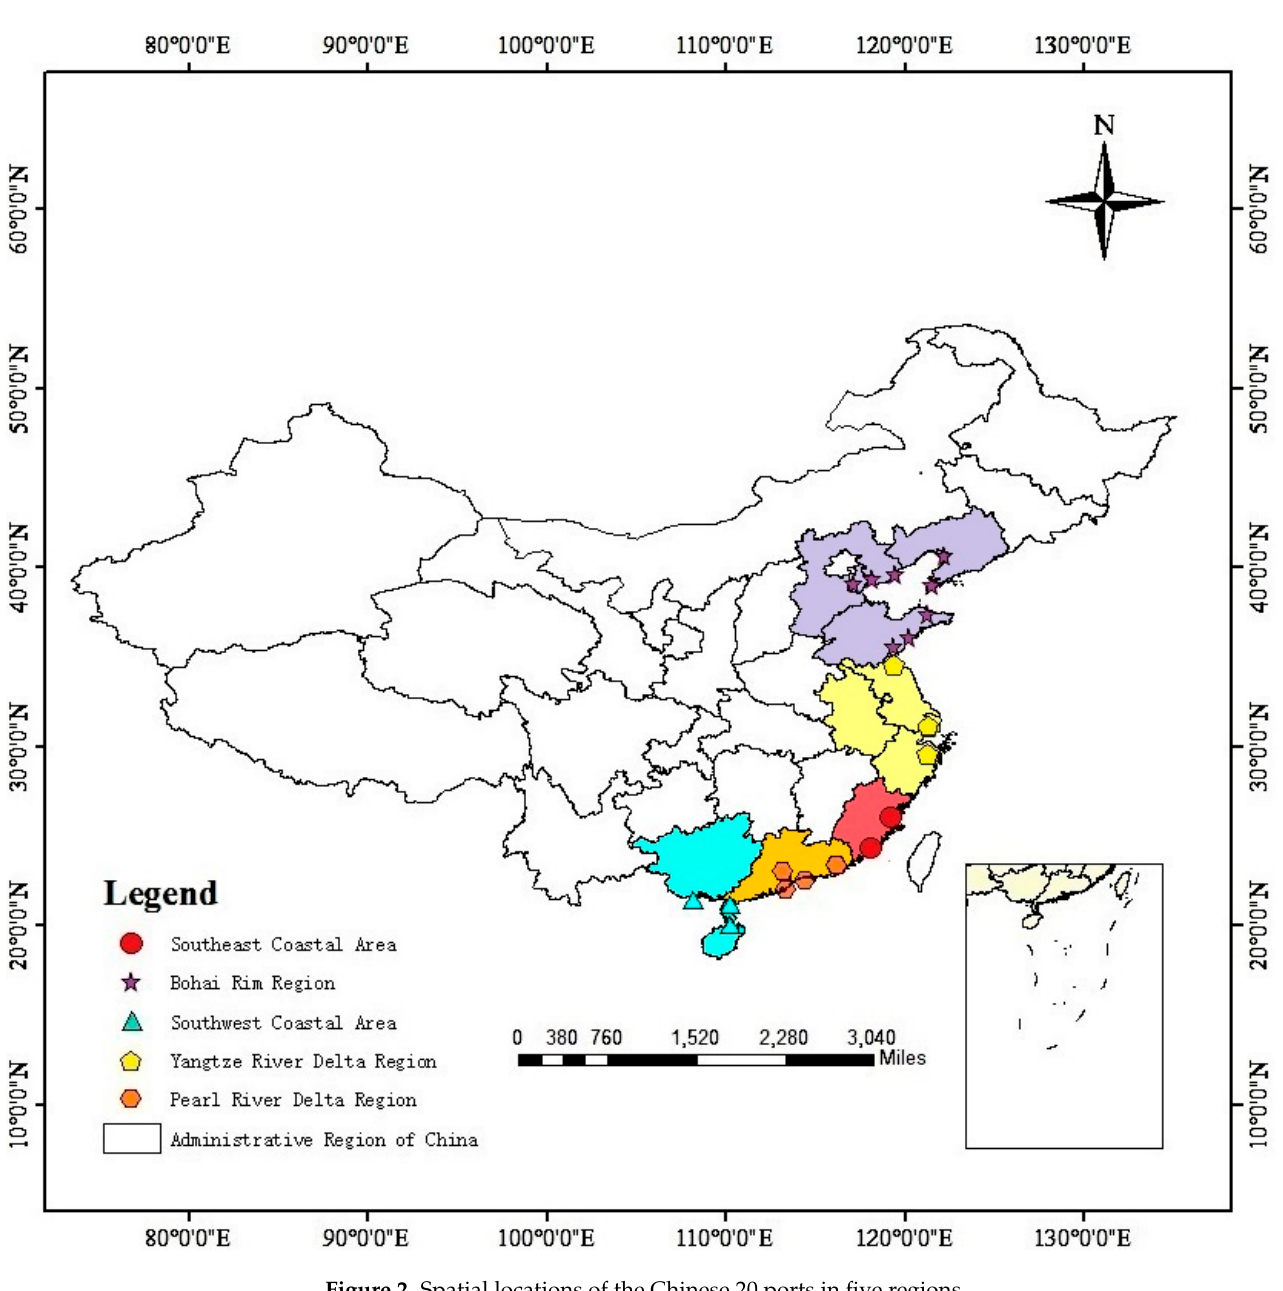
Figure 2. Spatial locations of the Chinese 20 ports in five regions.